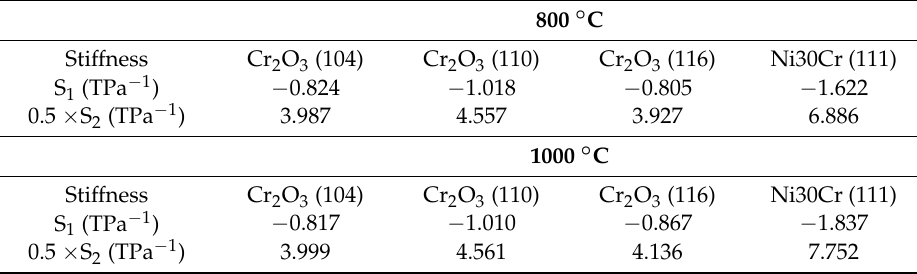
Table 2. Radiocrystallographic elastic coefficients.